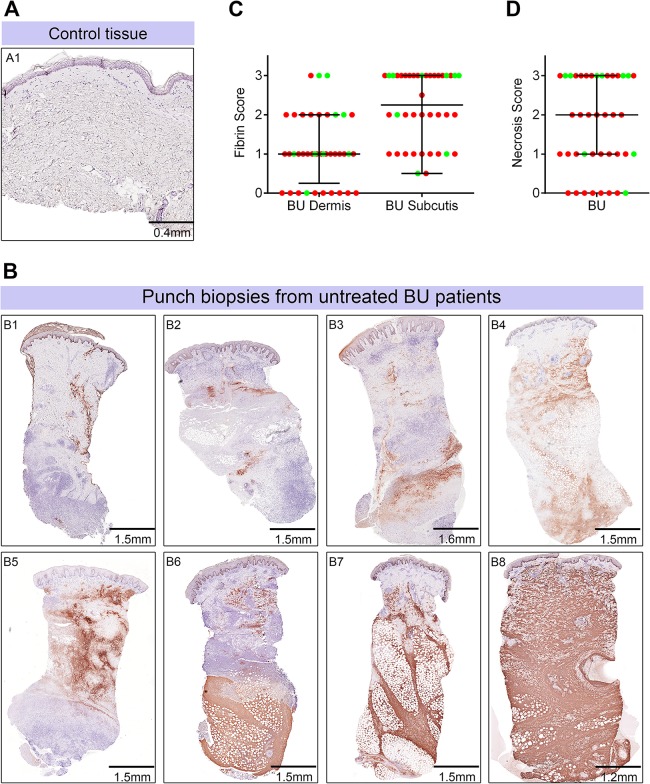
Abundant fibrin deposition in the skin of patients with Buruli ulcer.A and B. Histological sections were stained with an α-fibrin antibody and counterstained with Haematoxylin. Slides were analyzed with a DM2500 Microscope (Leica). Pictures were taken with an Aperio scanner. Comparative staining of a healthy skin sample from an unaffected donor (A) or 4mm punch biopsies from 8 different laboratory confirmed BU patients (B) showing the variability in fibrin staining observed ranging from small isolated fibrin depositions (B1-B2), to large deposition seen only in the dermis or subcutis (B3-B6) and finally to extensive depositions covering the whole tissue sample (B7-B8). C and D. Scoring was carried out as described in Materials and Methods and are relative to a maximum of 3. The score for each individual biopsy analysed is shown, consisting of 31 patients with ulcers (red circles) and 9 patients with plaque lesions (green circles). The expected score for healthy tissue was 0 for both fibrin and necrosis (see A). In all cases, error bars show the median and 25–75% percentile scores. C. Fibrin staining in the dermis and subcutis. D. The degree of necrosis in each biopsy was scored according to appearance of the entire biopsy.